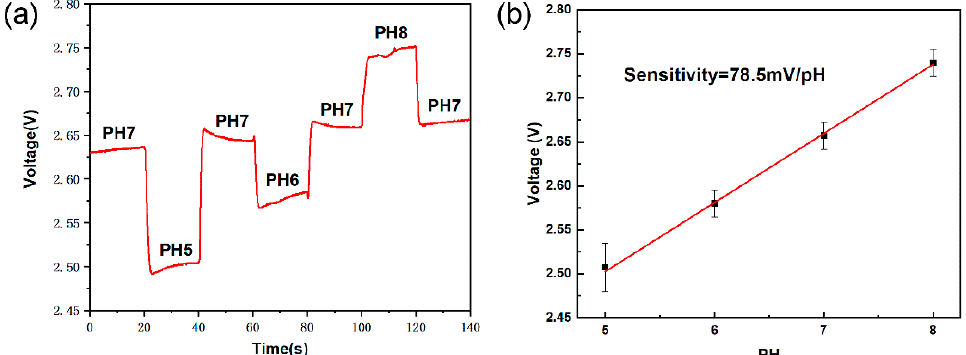
Figure 9. Test the pH sensitivity of the sensor chip. ( a ) The chip has a stable output for different pH values. ( b ) The sensitivity of the chip to the pH value is about 78.5 mV/pH.